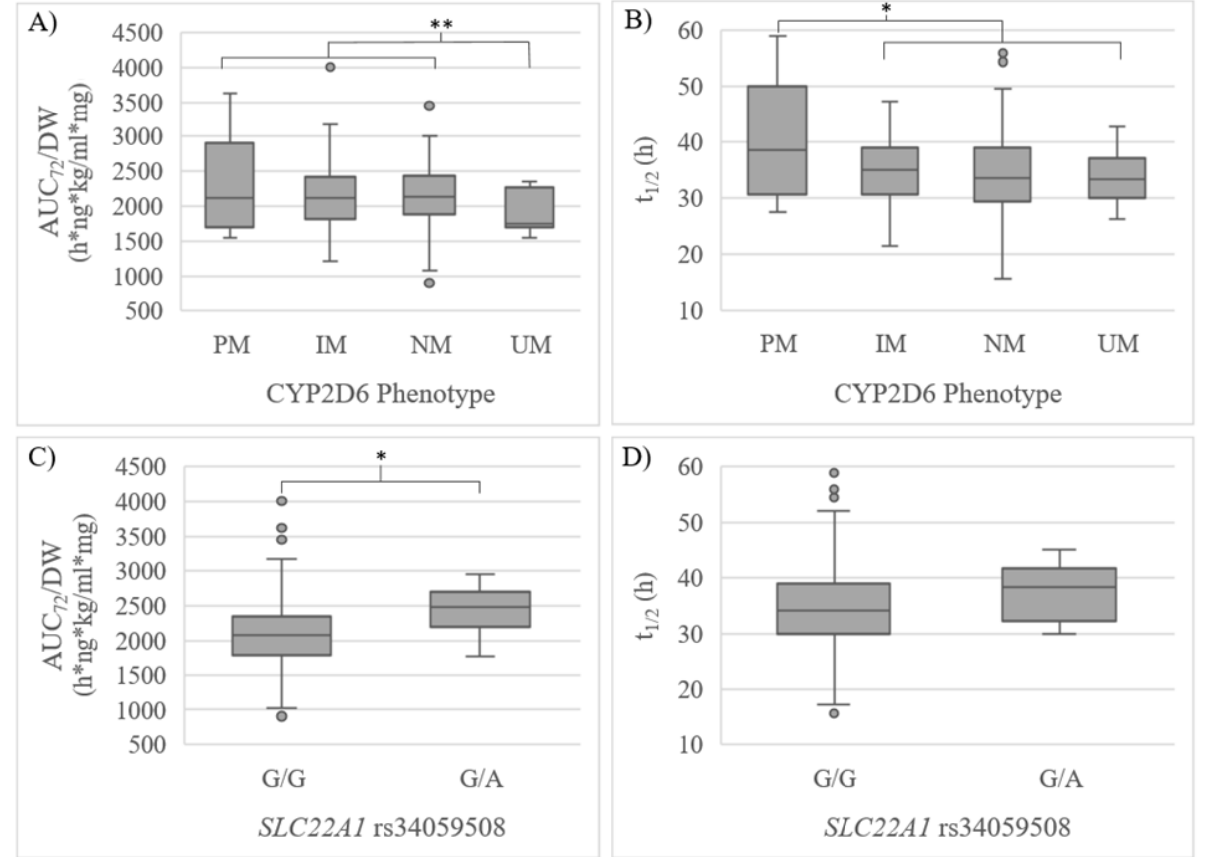
Figure 1. A) AUC 72 /DW and B) t 1/2 regarding CYP2D6 phenotype; C) AUC 72 /DW and D) t 1/2 re- Figure 1. ( A ) AUC 72 /DW and ( B ) t 1/2 regarding CYP2D6 phenotype; ( C ) AUC 72 /DW and ( D ) t 1/2 garding SLC22A1 rs34059508 in the confirmatory step. regarding SLC22A1 rs34059508 in the confirmatory step. UM: ultrarapid metabolizer, NM: normal metabolizer, IM: intermediate metabolizer, PM: poor metabolizer. * p < 0.05 in the univariate